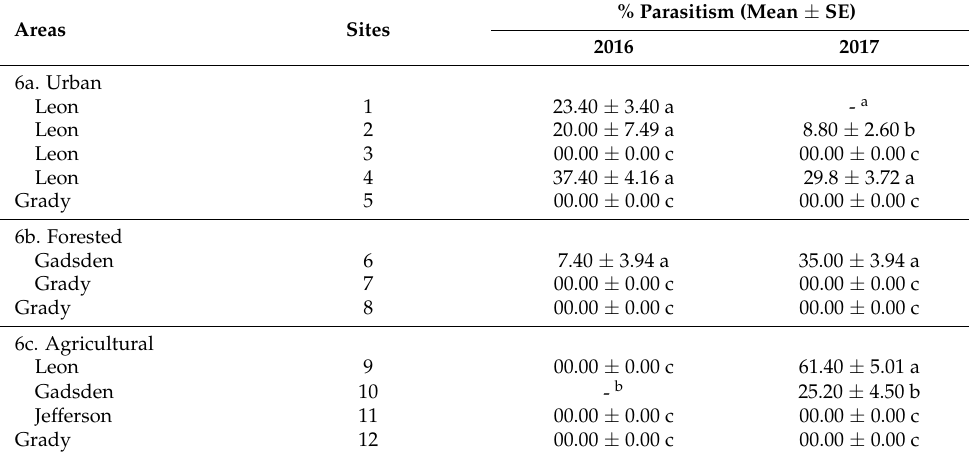
Table 2. Within-area comparison of M. cribraria eggs parasitized by P saccharalis in 2016 and 2017. Parasitism expressed as a percentage. Within each column, means followed by common letters are not significantly different (Tukey’s Studentized Range; p <